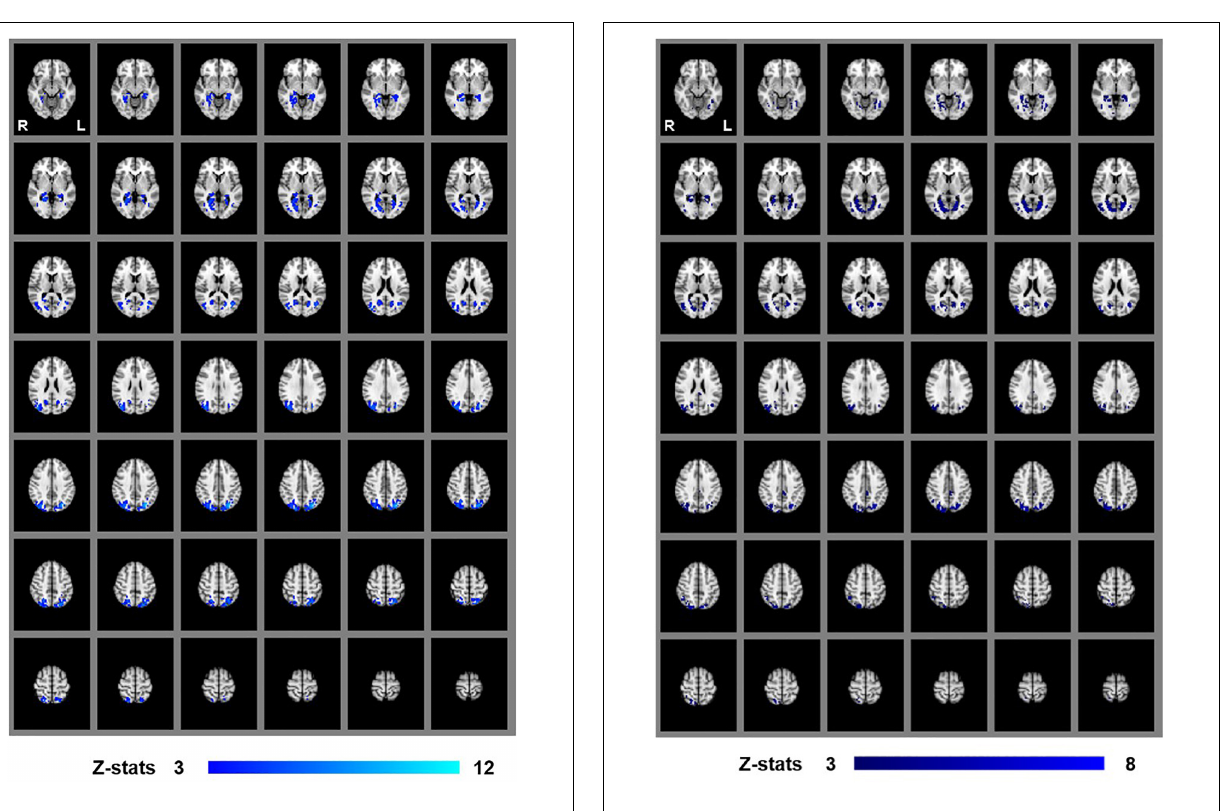
FIGURE 4 | Group results for binocular viewing, revealed by the fixed-effects ( N = 7) GLM contrast [BP INTACT > BP SCRAMB images]. All responses are masked to gray matter. Uncorrected p <